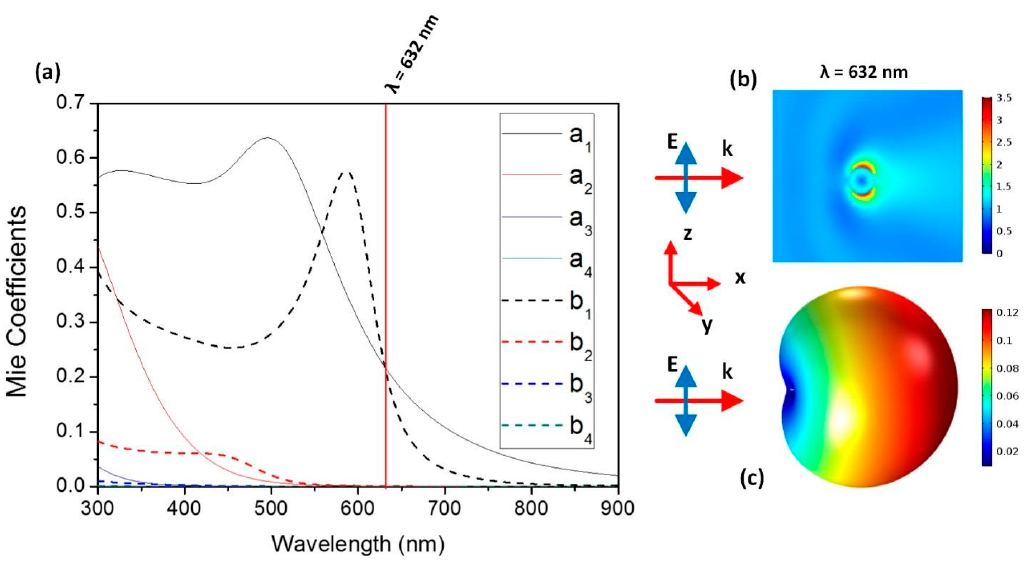
Figure 1. ( a ) Multipolar contributions towards the scattering cross section of a 184 nm-sized Cu 2 O sphere by applying x-polarized light at 632 nm wavelength. Calculated near-field ( b ) and 3D far-field ( c ) spatial distributions of the scattered field at a wavelength of 632 nm by FEM.